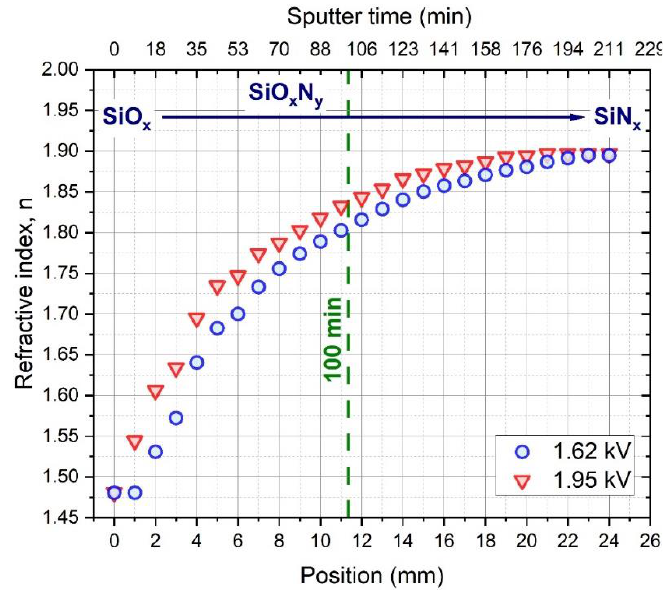
Figure 4. Refractive index (n) of the composition spread samples at 632.8 nm measured along the substrate by spectroscopic ellipsometry.